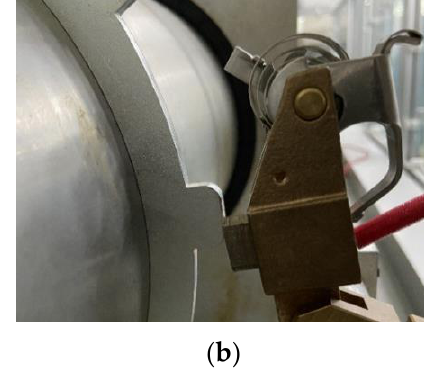
Figure 6. The specific coupling device: ( a ) passive shaft-grounding device and ( b ) saw-tooth-shaped connection device.